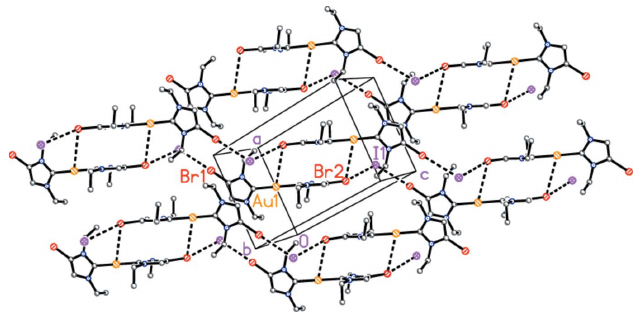
Figure 4 Packing diagram of compound 3 viewed perpendicular to (011). Hydrogen atoms are omitted. Dashed lines indicate halogen bonds or Au (cid:2)(cid:2)(cid:2) Br interactions. Atom labels correspond to the asymmetric